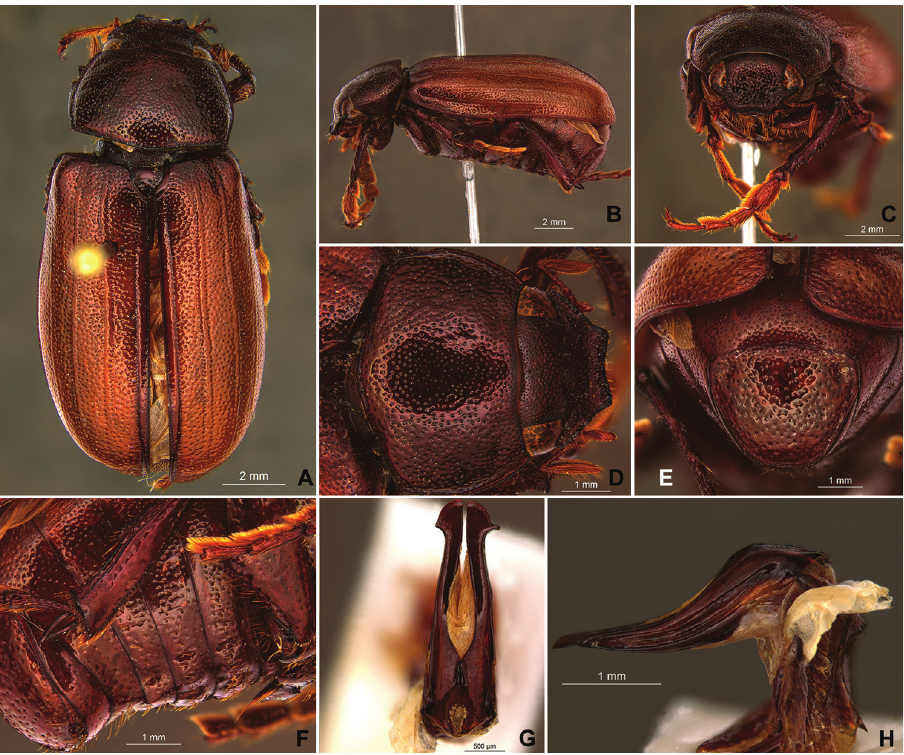
Figure 87. Liogenys sulcoventris Cherman, sp. n. A Dorsal view B Lateral view C Frontal view D Clypeus and pronotum E Pygidium F Abdomen, lateral view G Parameres, dorsal view H Parameres, lateral